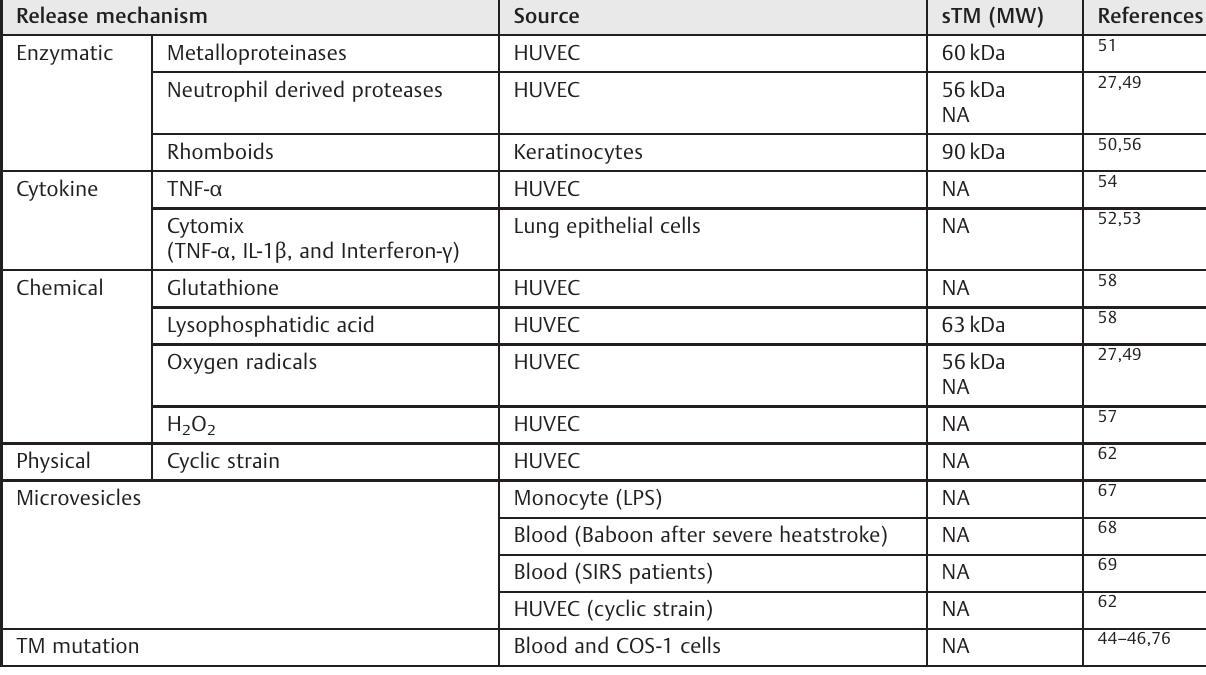
Table 1 Proteolytic and nonproteolytic release of membrane bound TM Release